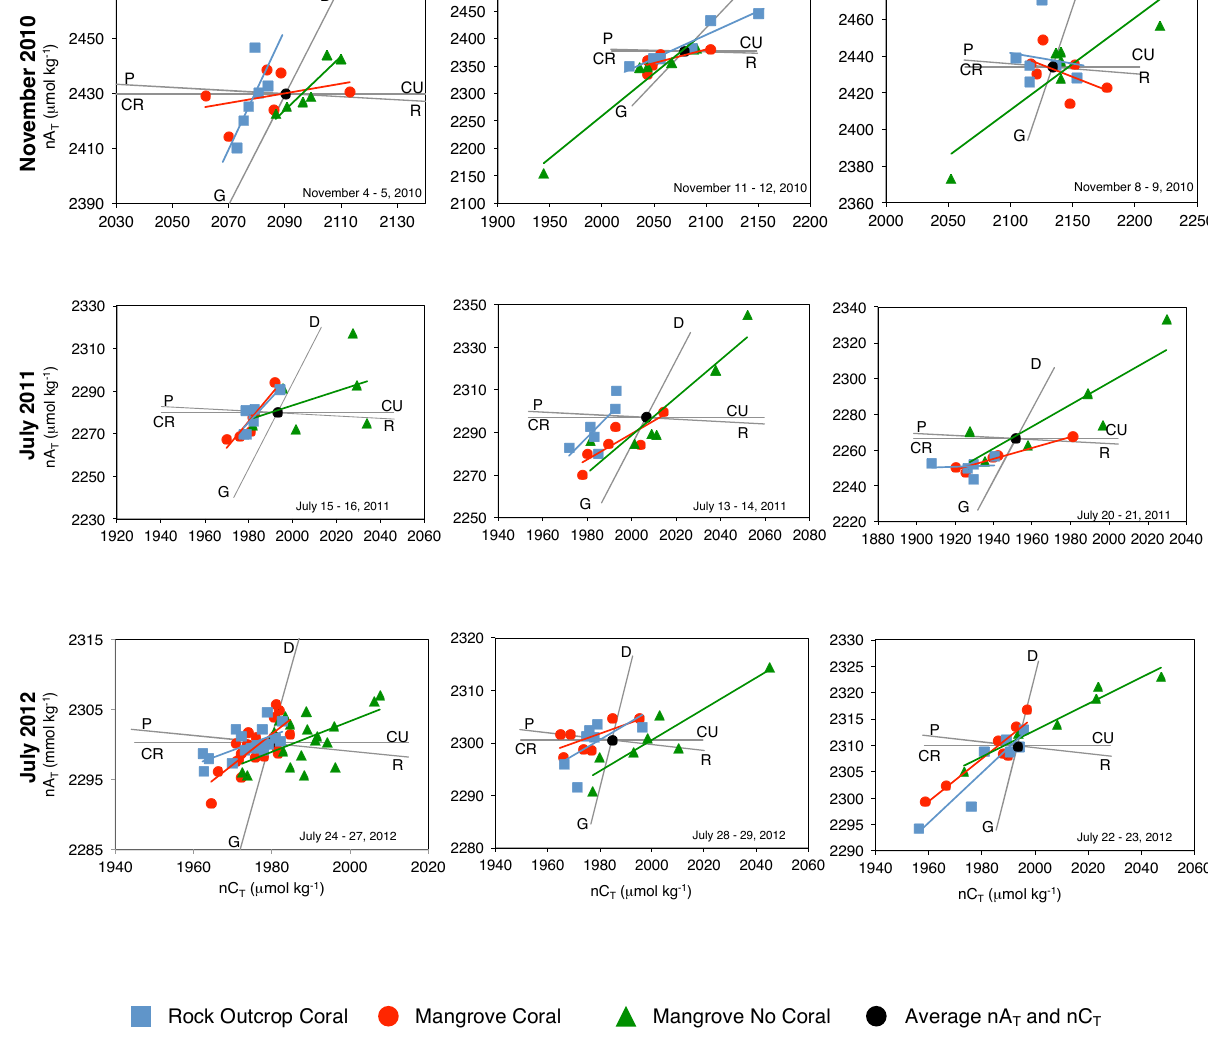
Figure 5. Salinity-normalized total alkalinity (nA T ) and total carbon (nC T ) plots with best-fit linear regressions (see Table 7 for equations and r 2 values) for November 2010, July 2011, and July 2012 in Otter Creek, Water Creek, and Princess Bay. Average nA T and nC T for each time period was calculated from all data collected from each site within each bay. Gray lines represent the theoretical impact of calcification (G), carbonate sediment dissolution (D), photosynthesis (P), respiration (R), CO 2 uptake (CU), and CO 2 release (CR) on A T and C T